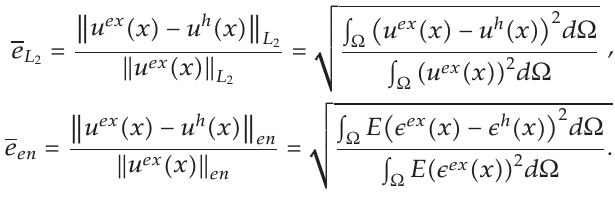
The stress at this scale was calculated from the second length scale. The second length scale was the dimension of the circular substructure radius which is 25 mm maximum.